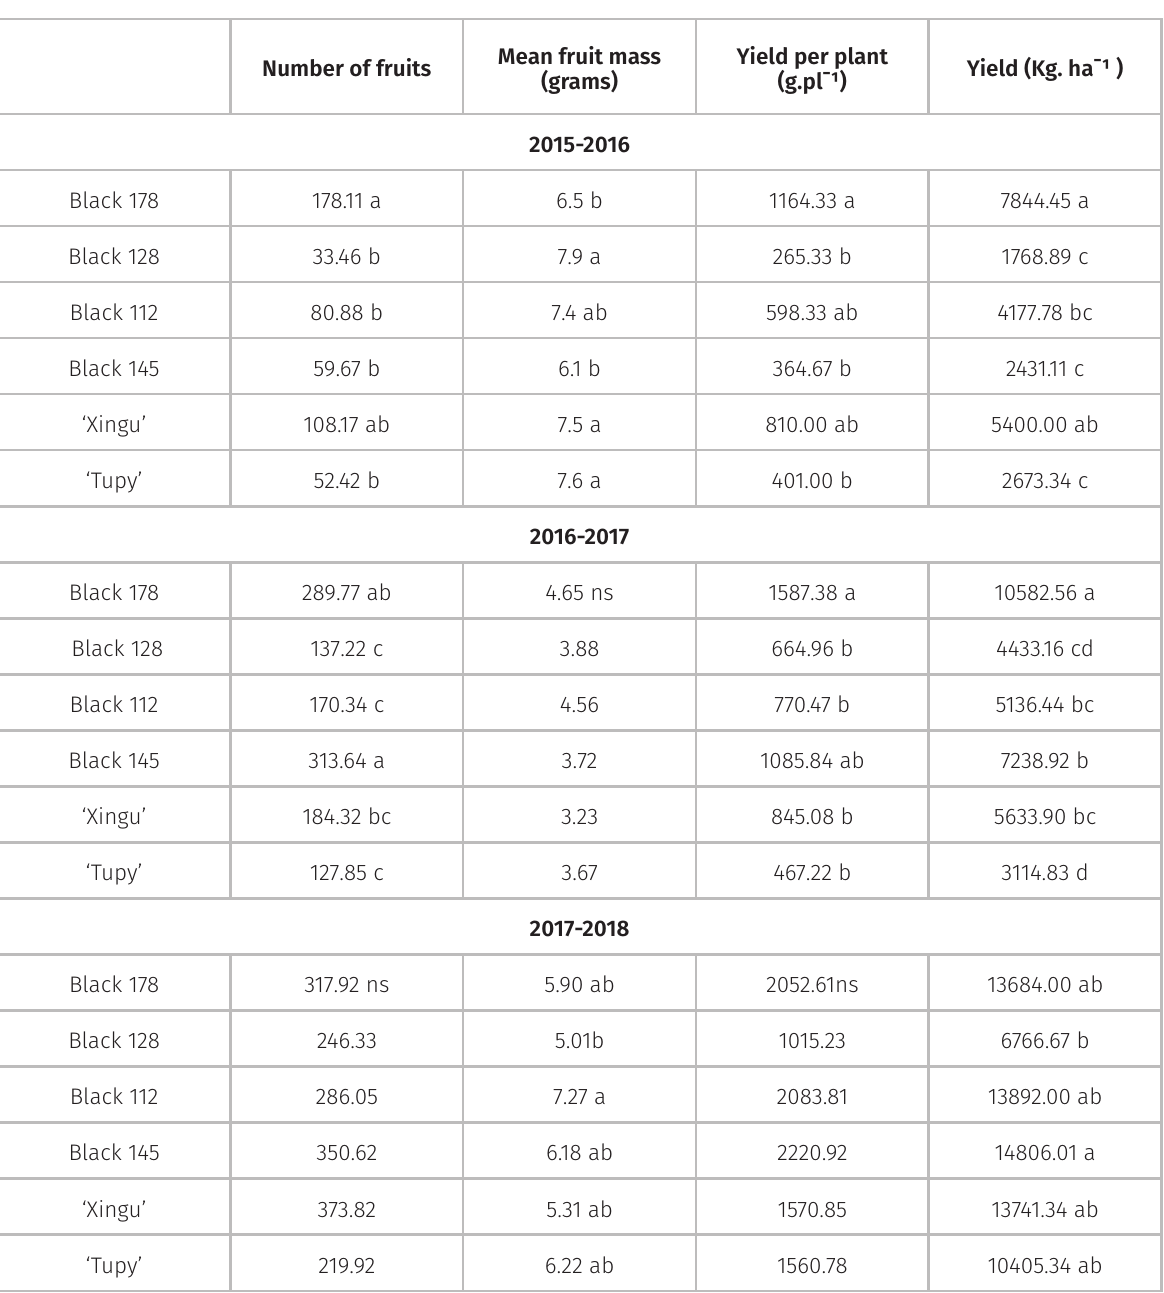
Table IV. Mean number of fruits. plˉ¹, mean fruit mass (MFM), yield per plant (g.plˉ¹) and yield kg.plˉ¹ of blackberry genotypes grown in an organic production system in 2015/16, 2016/17 and 2017/18 crops at the Estação Experimental Cascata (EEC). Pelotas, RS, Brazil 2017. Mean fruit mass Yield per plant Yield (Kg. haˉ¹ Number of fruits (grams) (g.plˉ¹)